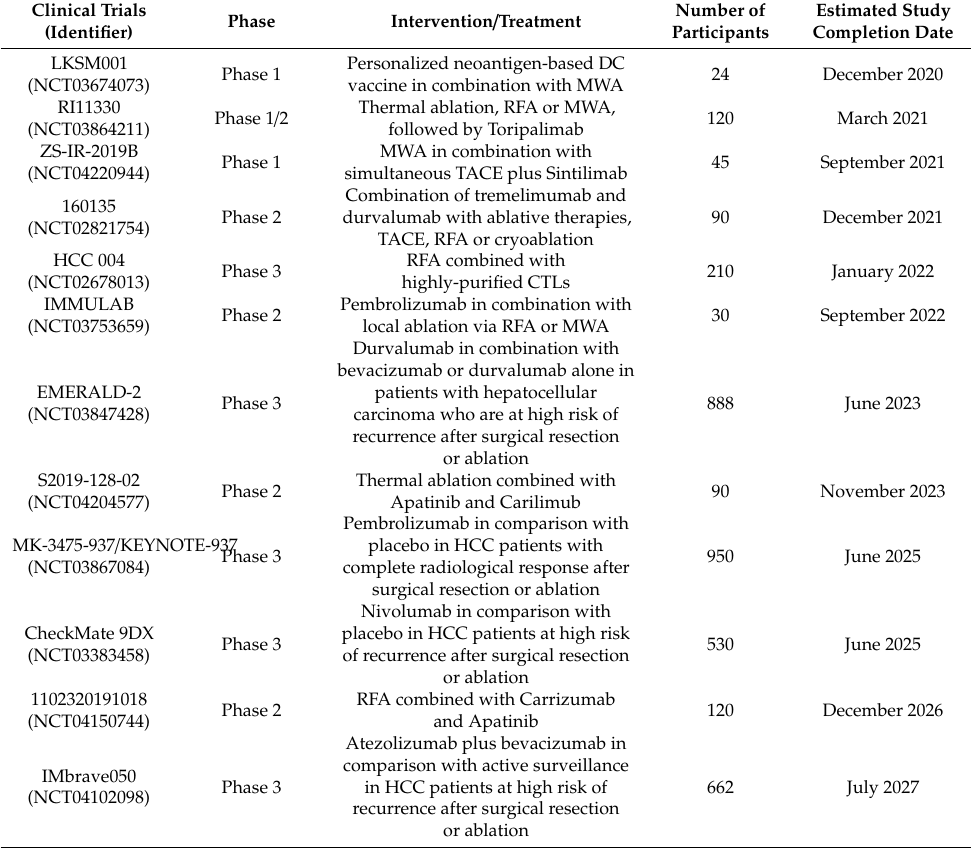
Table 2. Summary of principal clinical studies evaluating e ffi cacy of RFA or MWA in combination with